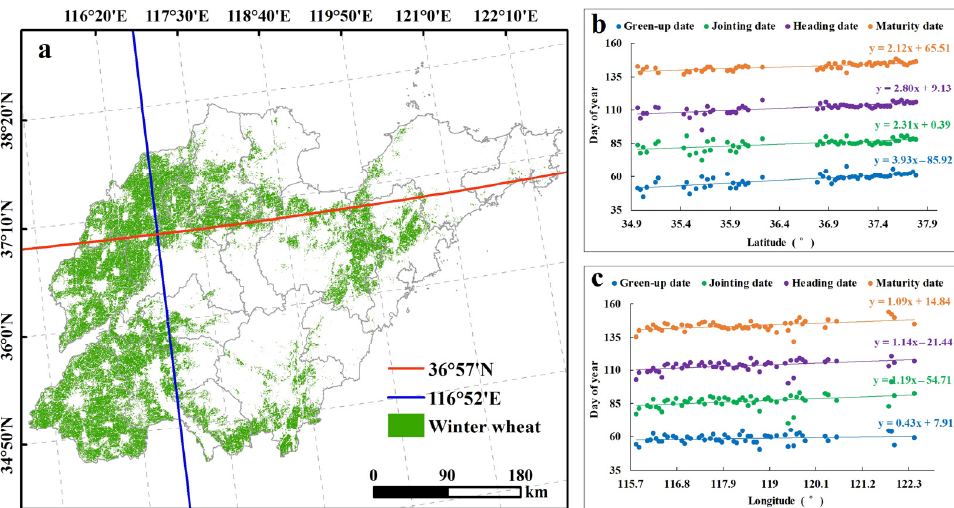
Figure 6. Latitudinal and longitudinal shifts in winter wheat phenology stages in Shandong Province. Subfigure ( a ) indicates the location of the transects, and subfigure ( b , c ) represent the latitudinal and longitudinal shifts in winter wheat phenology stages, respectively.